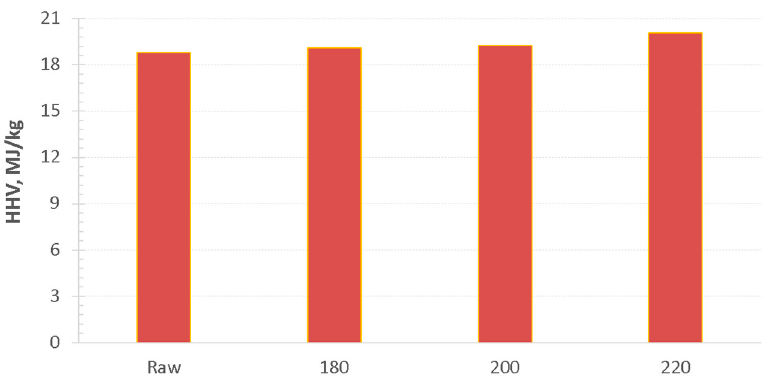
Figure 6. Proximate analysis of the raw sample, before HTC, and hydrochars obtained at respective temperatures.